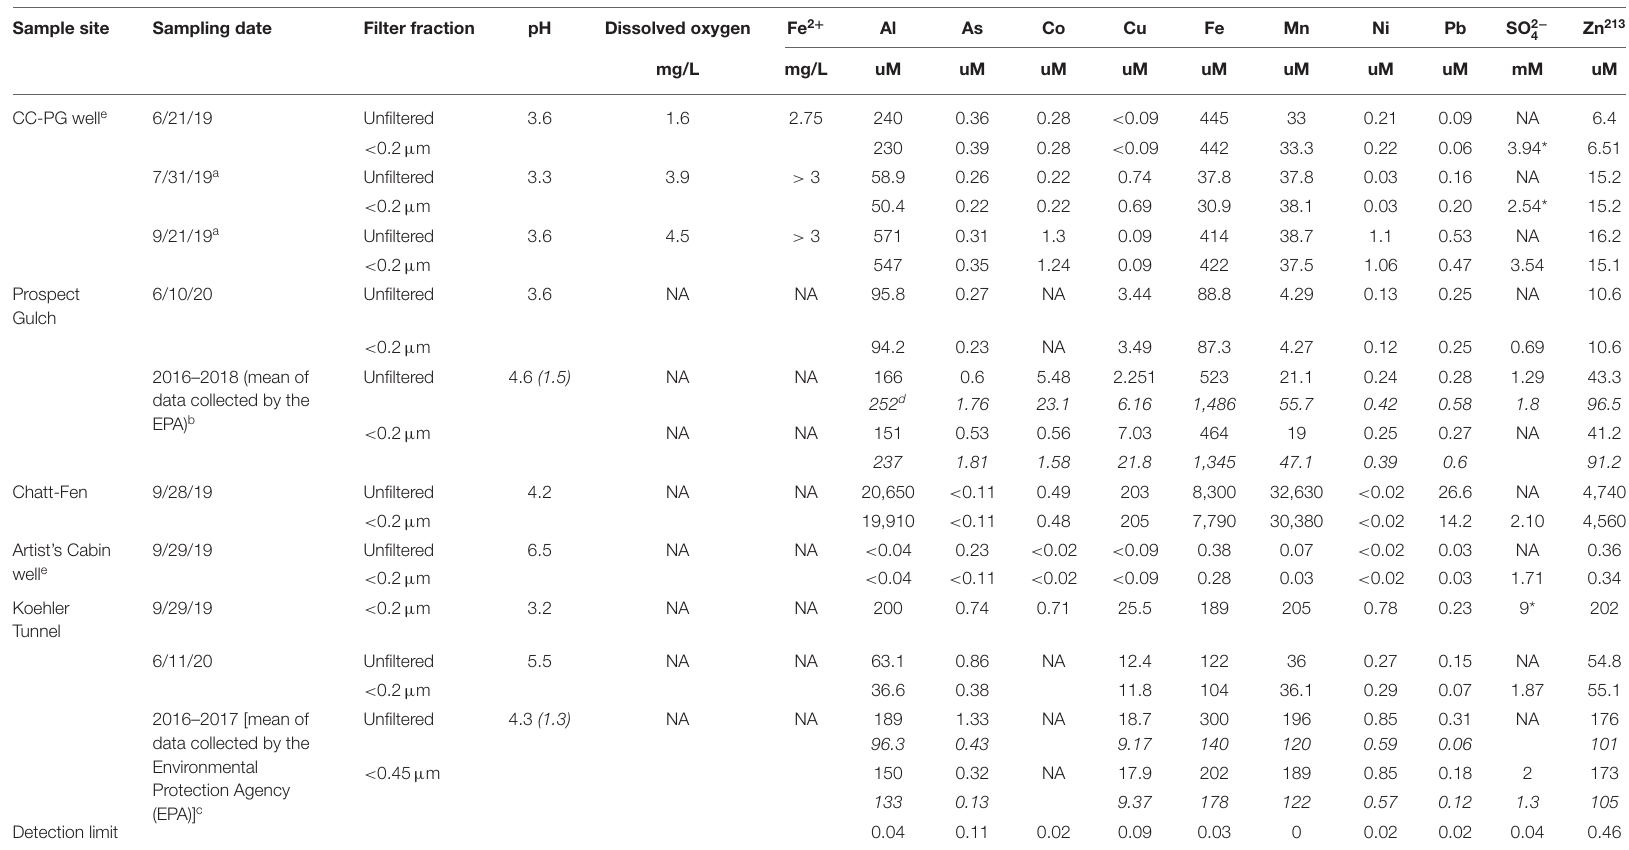
TABLE 4 | Groundwater, metal(loid) source, and iron fen trace metal(loid) and sulfur chemistry, including historical data from Koehler Tunnel and Prospect Gulch collected by the Environmental Protection